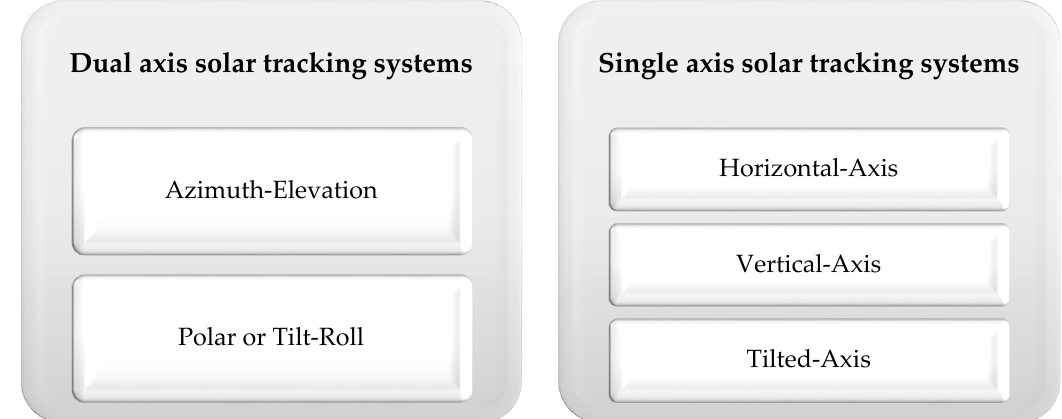
Figure 2. Types of solar tracking solutions according to [66,67].